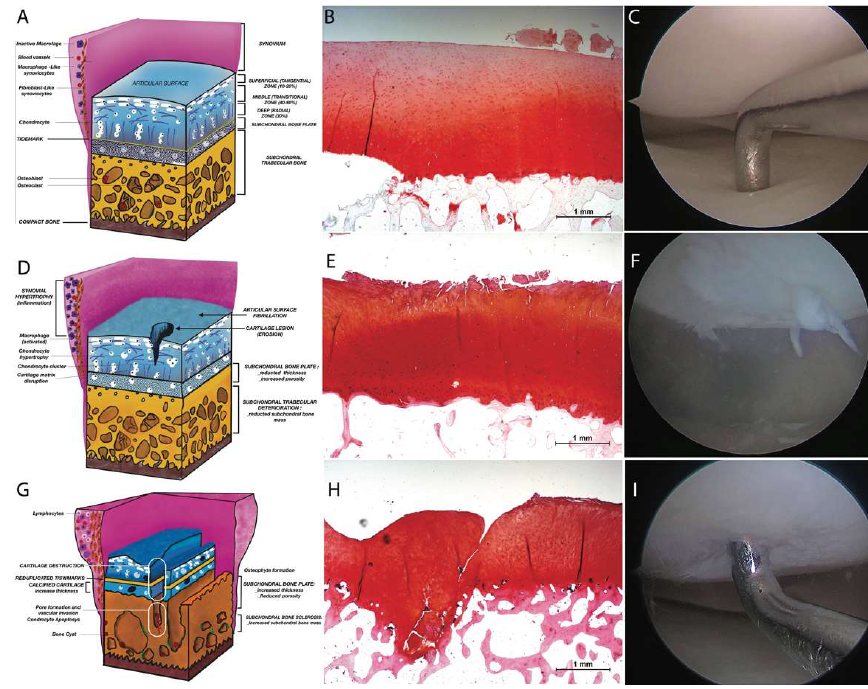
Figure 2. OA severity score by OARSI: ( A ): Grade 0, normal articular cartilage; ( B ): Grade 0 Histo- logical aspect; ( C ): Grade 0 Arthroscopic aspect; ( D ): Grade 3 Vertical clefts/erosion to the calcified cartilage extending to <25% of the articular surface; ( E ):Grade 3 Histological aspect; ( F ): Grade 3 Arthroscopic aspect; ( G ): Grade 6 Vertical clefts/erosion to the calcified cartilage extending to >75% of the articular surface, ( H ): Grade 6 Histological aspect; ( I ): Grade 6 Arthroscopic aspect. Table 1. Different evaluation score for